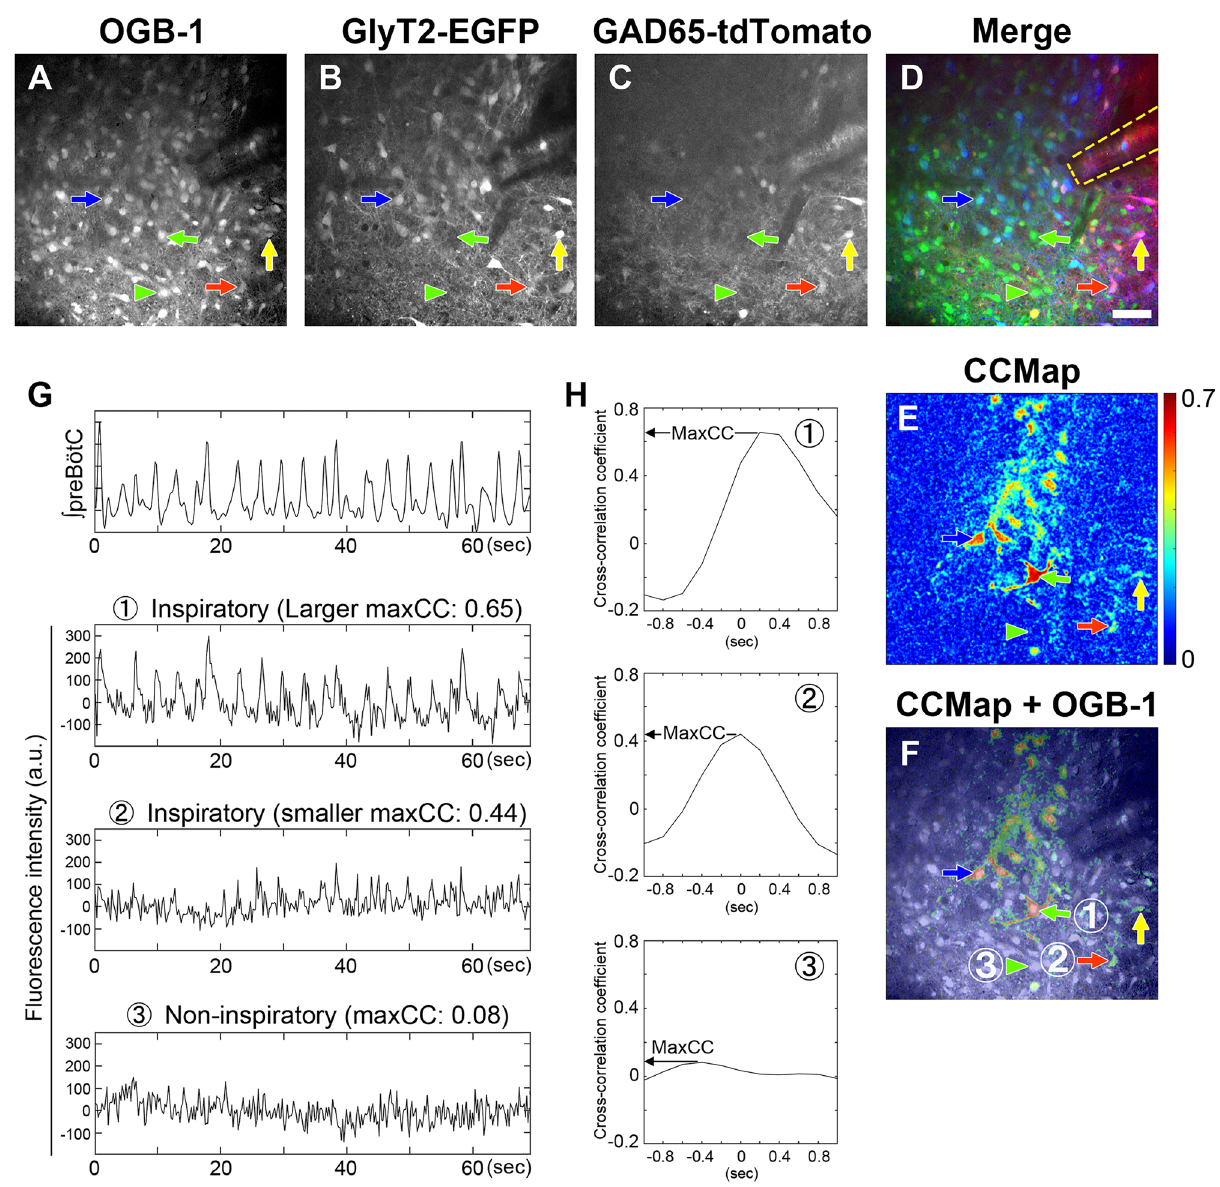
Figure 1. Genetic discrimination of inspiratory neurons in the preBötC using GlyT2-EGFP and GAD65- tdTomato double TG mice at p4. ( A–D) Fluorescence images of preBötC in slice preparation. ( A ) OGB-1 in all cells, ( B ) EGFP in GlyT2 + neurons and ( C ) tdTomato in GAD65 + neurons were visualized. ( D ) Overlay image of ( A–C ). Four representative types of cells are indicated by coloured arrows/arrowheads: blue, glycinergic neurons (GlyT2 + /GAD65 − ); red, GABAergic neurons (GlyT2 − /GAD65 + ); yellow, GGCN (GlyT2 + /GAD65 + , potential dual transmitting neurons); green, other cells, including excitatory neurons (GlyT2 − /GAD65 − ). ( E ) Cross- correlation (CC) mapping shows the maximum cross-correlation coefficient at individual pixels between the fluctuation pattern of OGB-1 fluorescence and the waveform pattern of integrated LFP. ( F ) CCmap ( E ) overlaid on ( A ). In ( A–F) , arrows and arrowheads indicate typical inspiratory and noninspiratory neurons, respectively. The outline of the glass suction electrode for recording LFP is denoted by a yellow dashed line in ( D ). The traces of the cells labelled by the circled numbers in ( F ) are shown in ( G,H) . The scale bar in ( D) is 50 µm and applies to ( A–F) . ( G ) Top trace: integrated LFP. From second top to bottom traces: raw traces of simultaneous OGB-1 fluorescence intensity in inspiratory neurons with larger and smaller maxCC or noninspiratory neurons, marked with the circled numbers in ( F) , respectively. Fluorescence intensity was measured within circles of radius 4 pixels (3.9 µm). ( H ) Each graph indicates the cross-correlation coefficient function calculated between the integrated LFP pattern and the time-shifted OGB-1 fluctuation pattern of each neuron shown by the circled number in ( F ). The maximum value within a time lag between −5 and 5 frames (approximately −1 and 1 s) was the maxCC of each